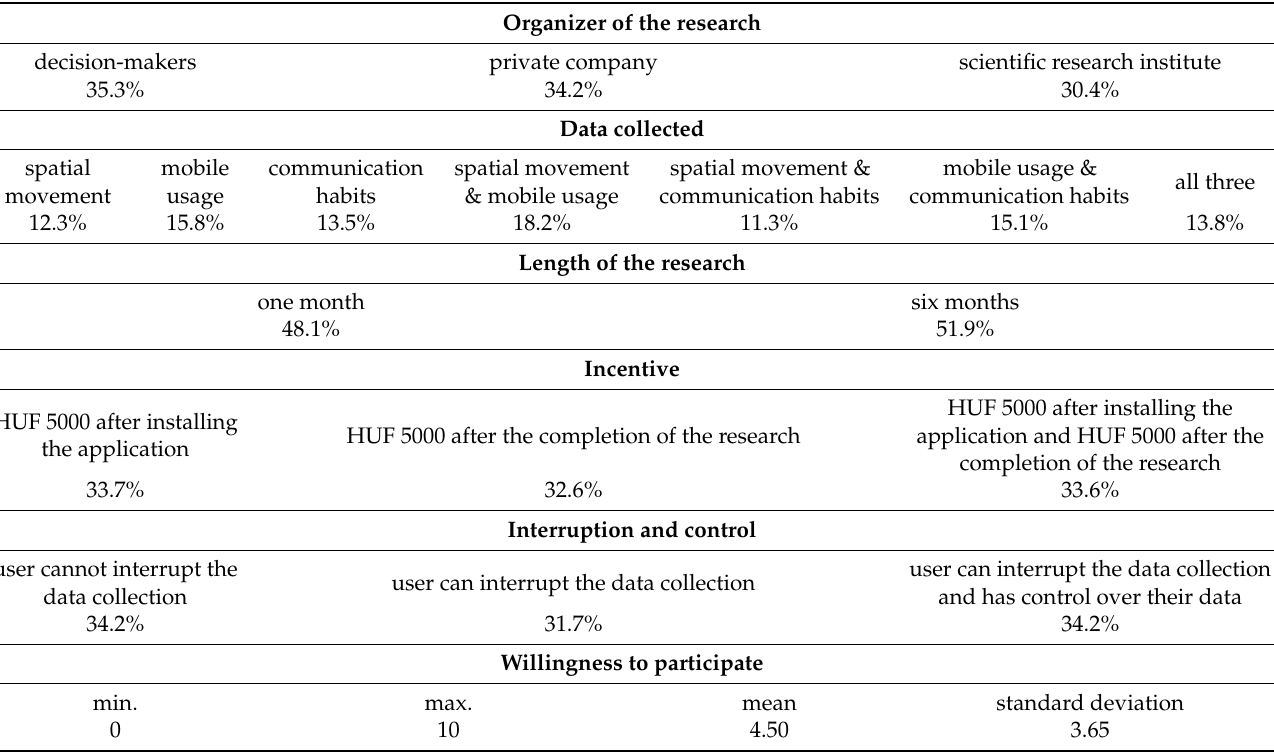
Table 2. The descriptive statistics of the dimensions of